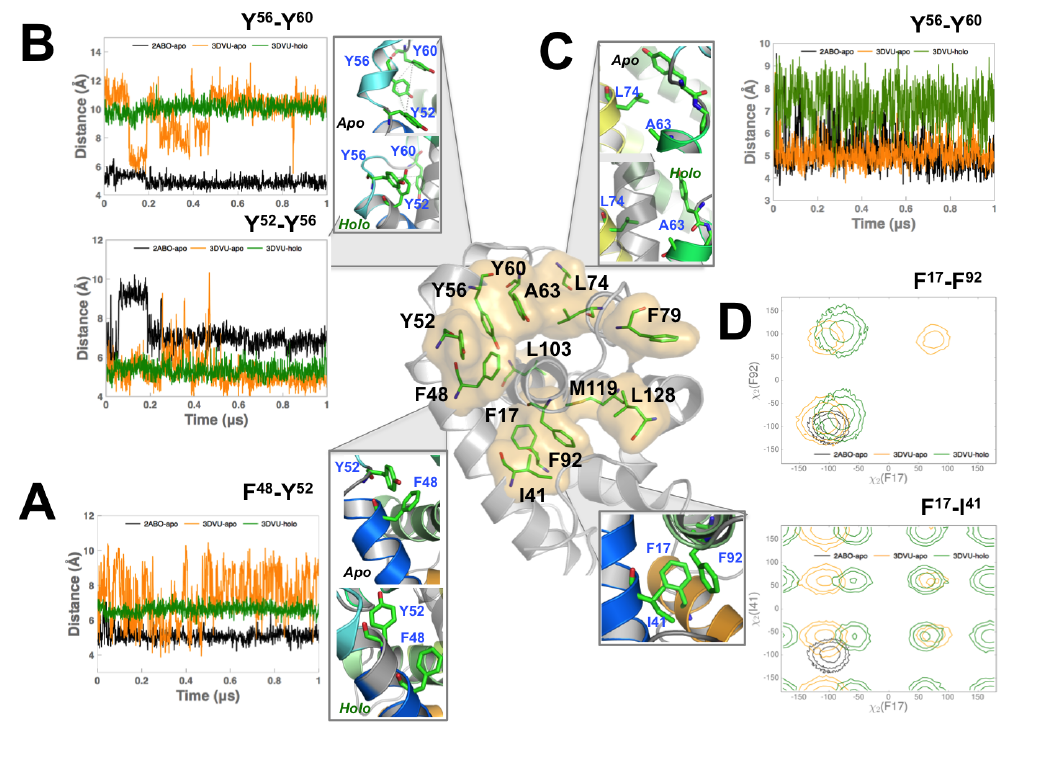
Figure 5. Mutations to Viral BCL2 protein (vBCL2) residues far away from binding groove significantly impact binding of BECN1 BH3 domain. ( A ) Distance variation of Phe48 with Tyr52 in the 2ABO-apo (black), 3DVU-apo (orange), and 3DVU-holo (green) simulations. Note that the increase in the flexibility for Phe48 when BECN1 BH3D is removed from the binding site. ( B ) Distance fluctuations of the C β atoms of Tyr52, Tyr56 and Tyr60 for the three simulations. While Tyr52-Tyr56 interaction in the 3DVU-apo simulation remains stable, a small segment of the simulation (from 0.2–0.4 µ s) indicates a partial unfolding in this region, sampling distances observed in the 2ABO-apo simulations. Tyr56-Tyr60 interaction on the other hand is stable in both the apo- and holo-M11 simulations, but undergoes dynamic fluctuations in the 3DVU-apo simulations. ( C ) Distance variation of Ala63 and its hydrophobic interactions with Leu74. Observe that upon binding BECN1 BH3D, the fluctuations in the distance between the C β atoms of Ala63 and Leu74 increase when compared to the 2ABO-apo and 3DVU-apo simulations. ( D ) Hydrophobic interactions between Phe17, Phe92, and Ile41 quantified by the χ 2 angle distributions of their respective side-chains. Up to three standard deviation intervals from the mean value of the χ 2 values are depicted using respective color schemes that are described for the three simulations. For the Phe17-Ile41 side chain interaction, note that the 2ABO-apo simulations only sample a narrow range of χ 2 angles; the 3DVU-holo and 3DVU-apo simulations sample additional states not seen in the 2ABO-apo simulations. For the Phe17-Phe92 interaction, there is overlap between the apo- and holo-M11 simulations, but the 3DVU-apo and 3DVU-holo simulations sample additional states not seen by the 2ABO-apo